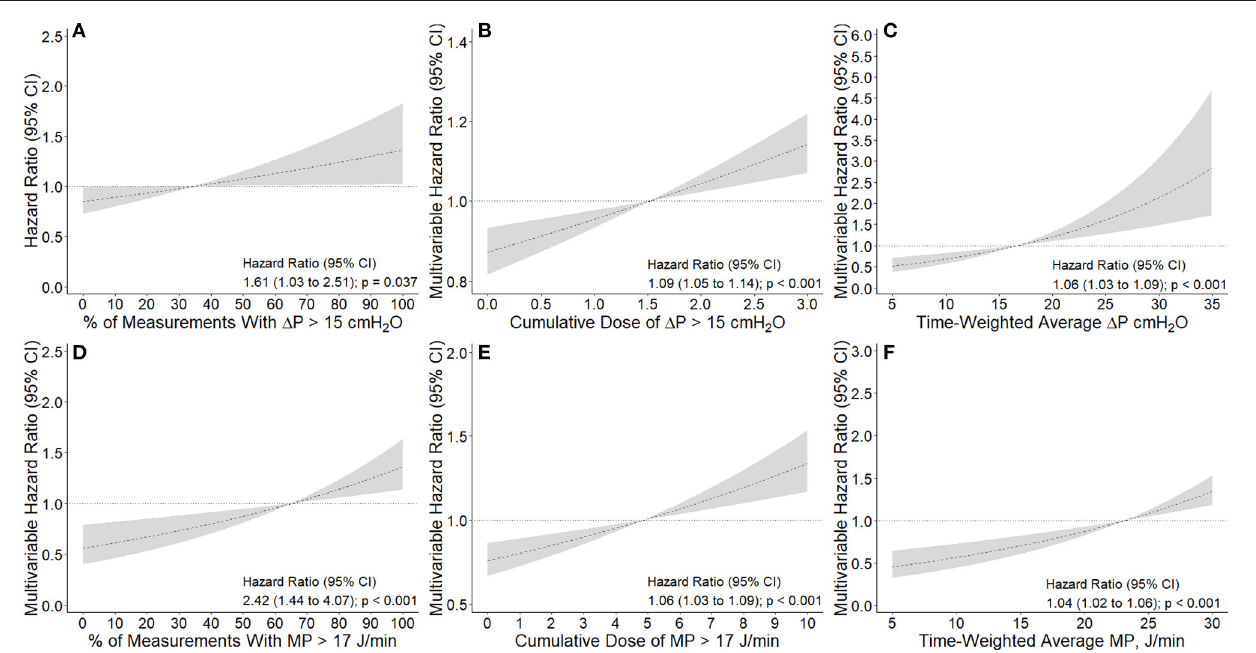
FIGURE 3 | Association between intensity of exposure to higher driving pressure and mechanical power and 28-day mortality. (A, D): Association between percentage of measurements with 1 P > 15 cmH 2 O and MP > 17 J/min and 28-day mortality. Percentage calculated from a maximum of 13 measurements extracted every 8h. (B, E): Association between cumulative dose of 1 P > 15 cmH 2 O and MP > 17 J/min and 28-day mortality. Cumulative dose calculated as area under the 1 P and MP time curve above the thresholds described above divided by the number of hours of exposure, as a measure of dose. Using this definition, 1 cmH J/min of dose describes that a patient’s average 1 P or MP was 1 cmH 2 O or 1 J/min above the thresholds described for the duration of the exposure window, respectively. (C,F) Association between time-weighted average 1 P and MP and 28-day mortality. Time-weighted average calculated as the area under the 1 P and MP time curve divided by the number of hours of exposure. All models were adjusted for age, gender, body mass index, PaO 2 to FiO 2 ratio, plasma creatinine, medical history of hypertension, heart failure, diabetes, chronic kidney disease, chronic obstructive pulmonary disease, active hematological neoplasia and/or active solid tumor, use of angiotensin converting enzyme inhibitors, use of angiotensin II receptor blockers, use of a vasopressor or inotropes, fluid balance, arterial pH, mean arterial pressure, and heart rate. Dashed lines and gray areas represent hazard ratio and 95% confidence interval for increasing values the variable analyzed as a continuous variable and centralized in the mean of each variable. 1 P is driving pressure and MP is mechanical power